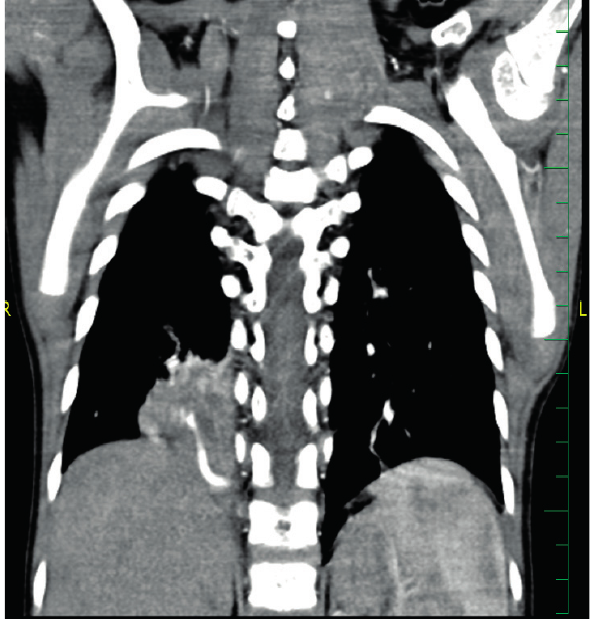
Fig. 3. A coronal CT reconstruction, mediastinal windowing, shows contrast enhanced a systemic arterial feeder to the pul- monary sequestration of the right lower